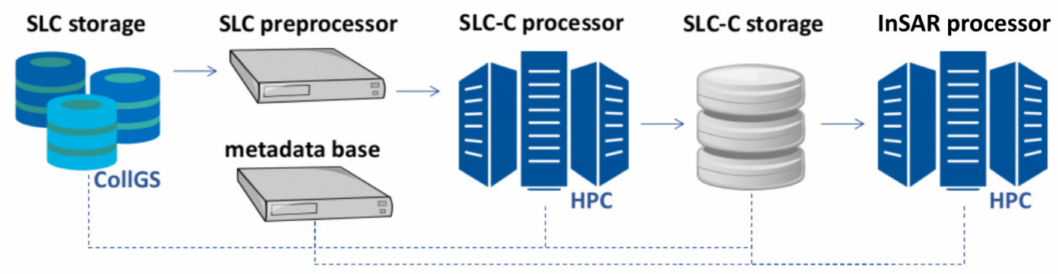
Figure 2. Architecture of IT4S1 system modules generating Sentinel-1 burst SLC-corrected (SLC-C) data and their interferometric